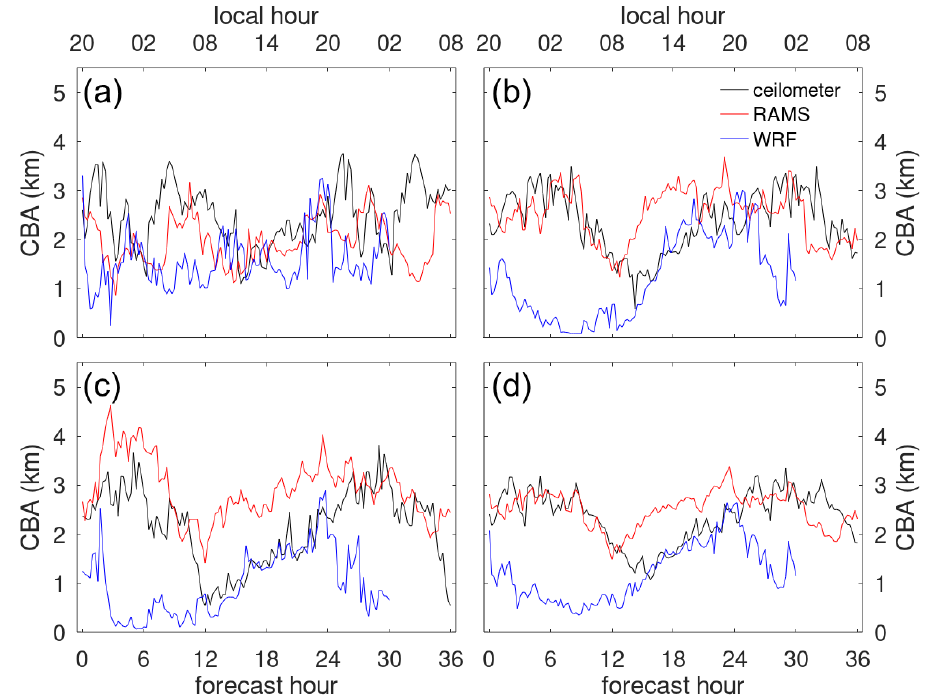
Figure 2. Monthly averaged 15-min cloud base altitude (CBA) for the ceilometer (black), RAMS (red), and WRF (blue) for ( a ) April, ( b ) May, ( c ) June, and ( d ) April to June.